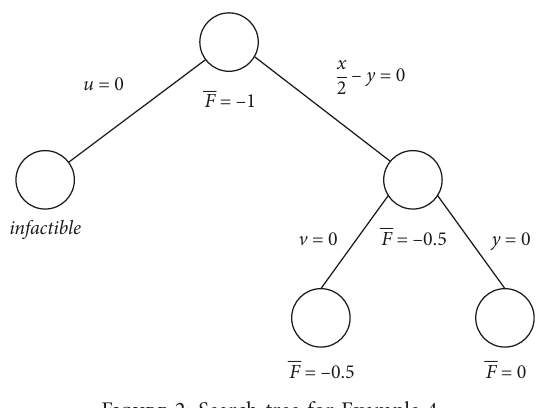
Figure 2: Search tree for Example 4.